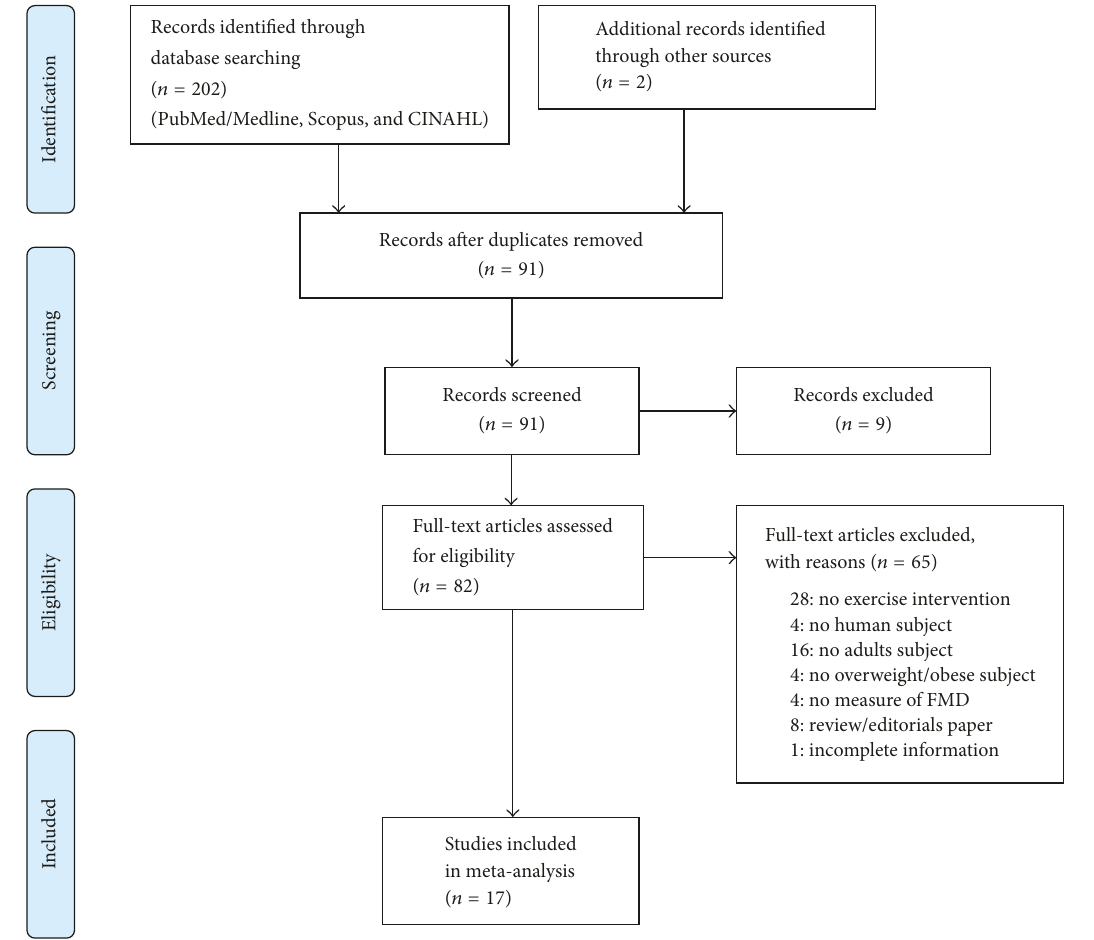
Figure 1: Flowchart for selection of